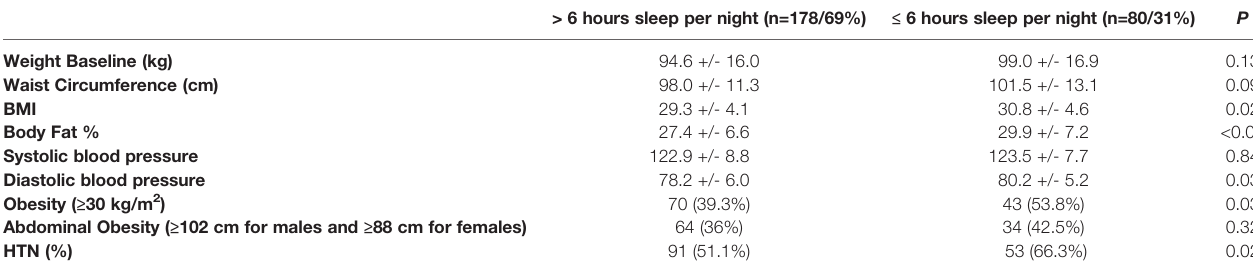
BMI, body mass index; HTN,